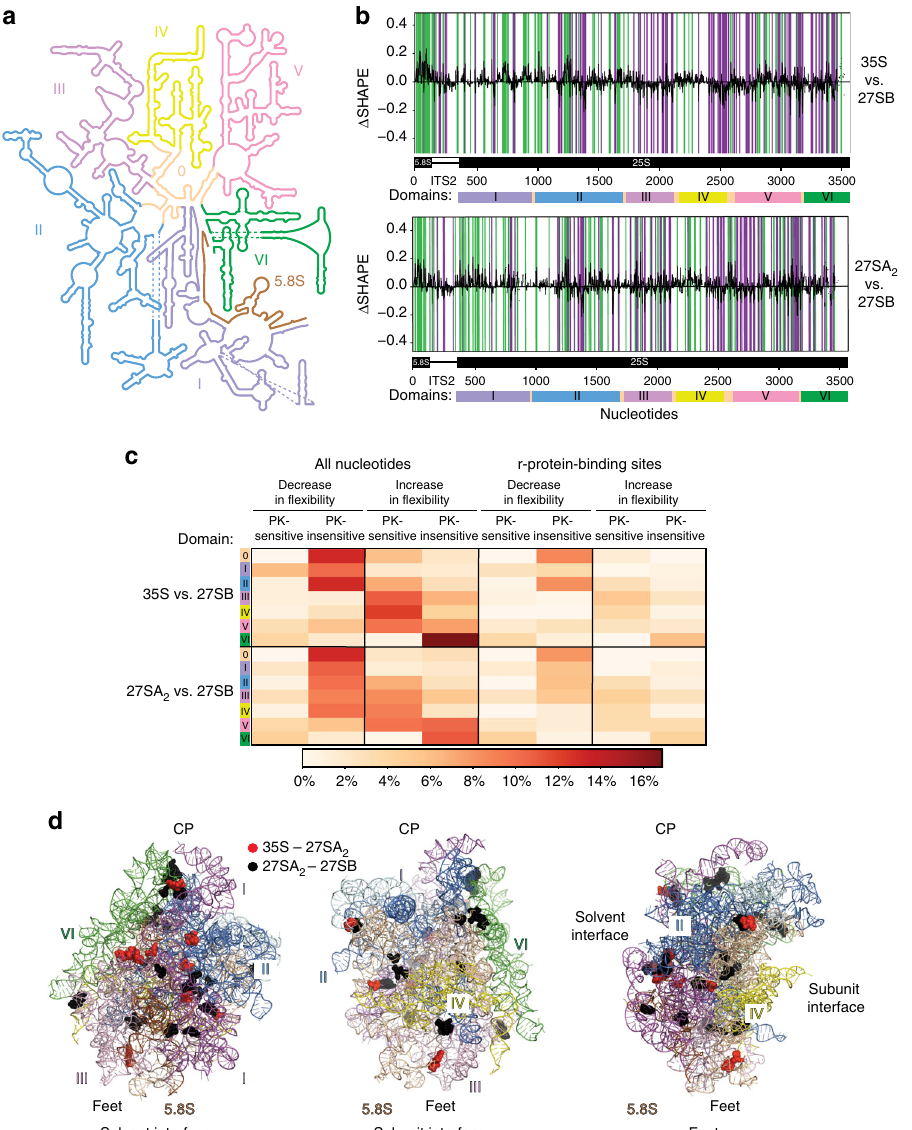
Fig. 3 Folding of 25S rRNA domains. a Secondary structure model for the 25S and 5.8S rRNAs generated using RiboVision 64 . The individual domains are colored. b Differential SHAPE ( Δ SHAPE) analysis of 35S, 27SA 2 , and 27SB particles. The histograms show a comparison between 35S and 27SB data and 27SA 2 compared to 27SB data. If a region is highlighted in green , then it is more reactive in the 35S ( top ) or 27SA 2 ( bottom ) data. If a region is highlighted in purple , it is more reactive in the 27SB data. Δ SHAPE reactivities were calculated as using code developed by the Weeks lab 36 . c The heat map indicates the percentage of nucleotides in each 25S rRNA domain (indicated on the left side of each domain) that showed a decreased or an increase reactivity when comparing the various particles (35S vs. 27SB and 27SA 2 vs. 27SB) as well as whether these changes were sensitive or insensitive to PK treatment. Shown are the results for all the nucleotides as well as the nucleotides that overlapped with r-protein-binding sites in the 60S crystal structure 35 . d Overview of the PKSRP sites in the three-dimensional structure of the 25S rRNA 35 . Most of the proposed protein – rRNA interactions are concentrated on the solvent interface, with fewer PKSRP sites identi fi ed on the subunit interface, central protuberance (CP), and feet. Protein-binding sites were de fi ned according to the crystal structure of the ribosome